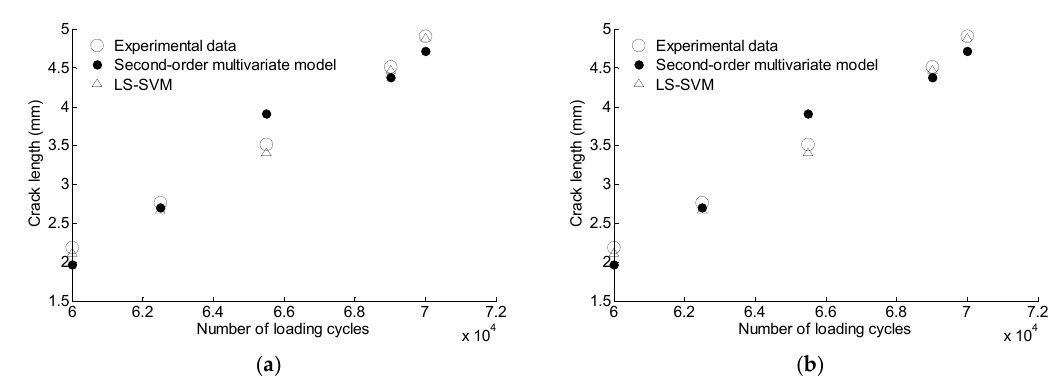
Figure 22. The comparison of prediction data based on second-order multivariate model and GA based LS-SVM. ( a ) S1; ( b ) S5.